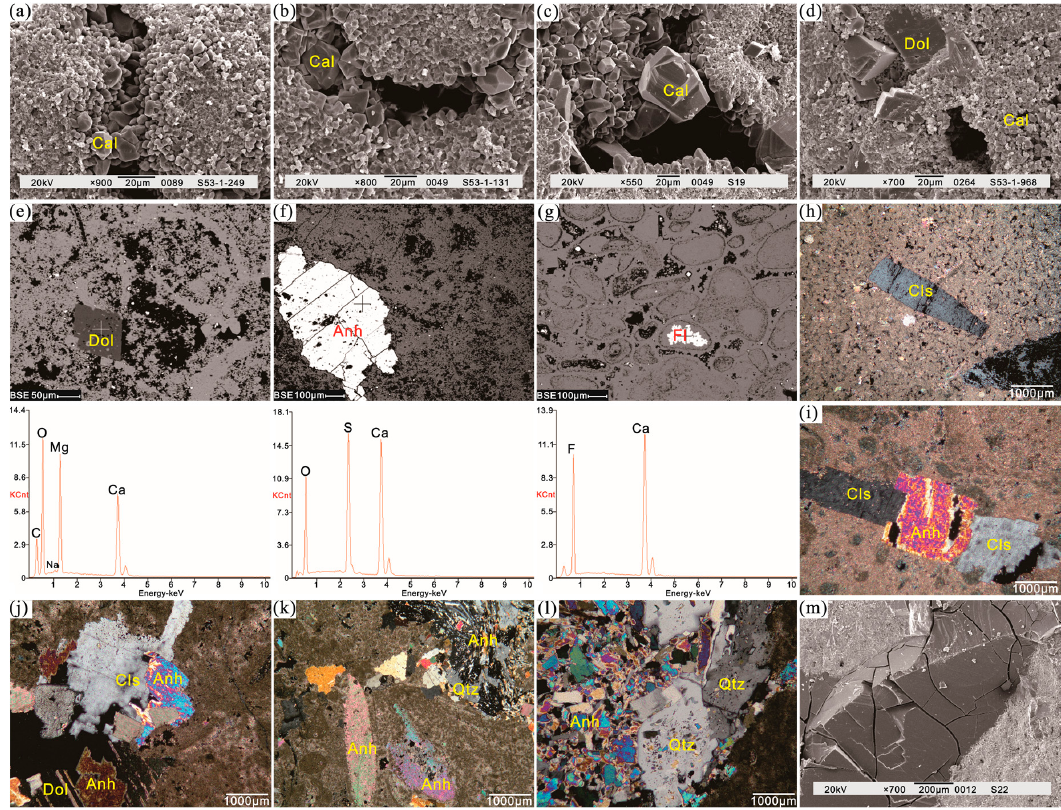
Figure 13. Typical microscopic photographs of mineral types and their syngenetic sequence. ( a ) Intergranular pores filled with calcite crystals, peloid packstone, 2404.23 m, XVp, SEM; ( b ) Intergranular pores partially filled with secondary calcite crystals, bioclastic packstone, 2384.35 m, XVp, SEM; ( c ) Primary skeletal pores partially filled with secondary calcite crystals, and the horse—tooth—shaped secondary calcite crystals grew along the pore walls, bioclastic wackestone, 2491.79 m, XVm, SEM; ( d ) Secondary rhombic dolomite shows intact crystal shape, micrite, 2519.92